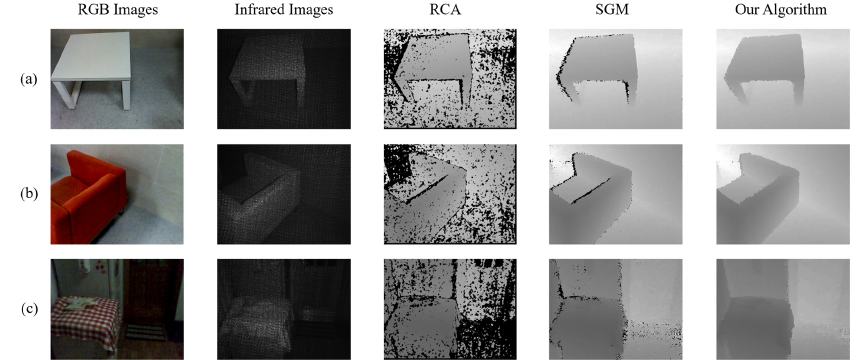
Figure 3 . Comparison of results of different methods. (a–c) correspond to three